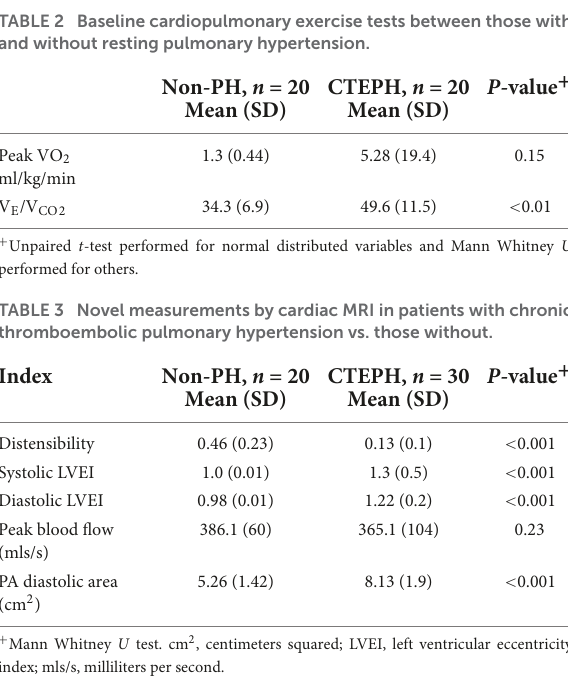
Table 3 . Pulmonary artery distensibility was significantly